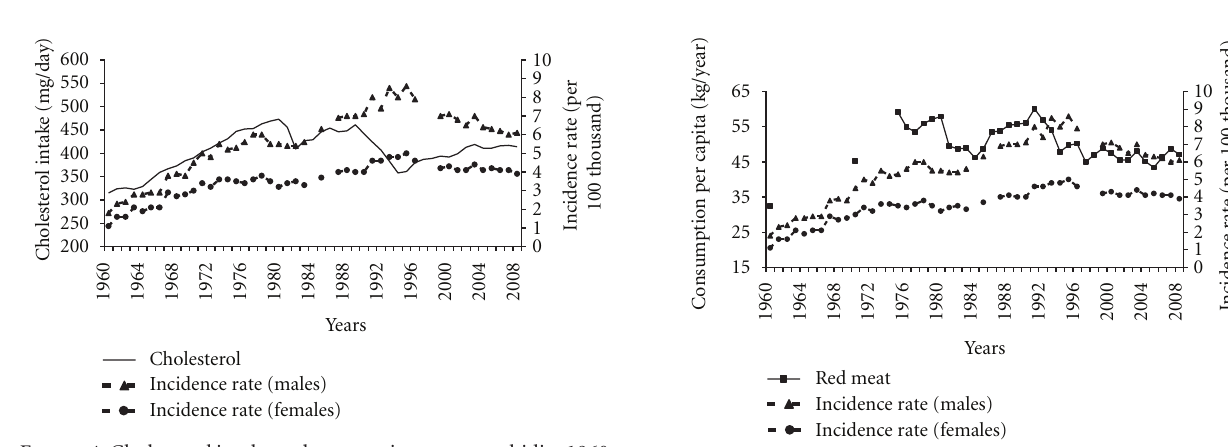
Figure 6: Red meat consumption and pancreatic cancer morbidity 1960–2008.